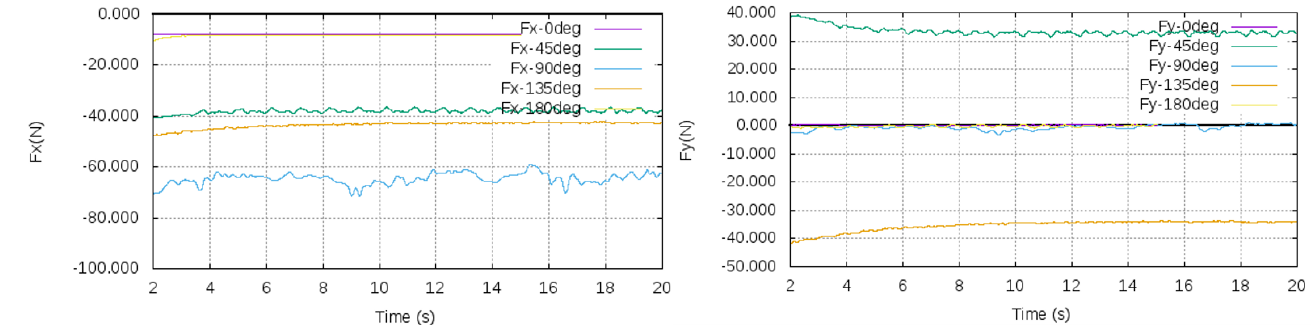
Figure 6. Drag and transverse force time history for bow, bow quartering, beam, stern quartering, and stern wind inflow conditions. In the figure, purple represents 0°, green 45°, blue 90°, orange 135°, and yellow 180° of the wind direction.